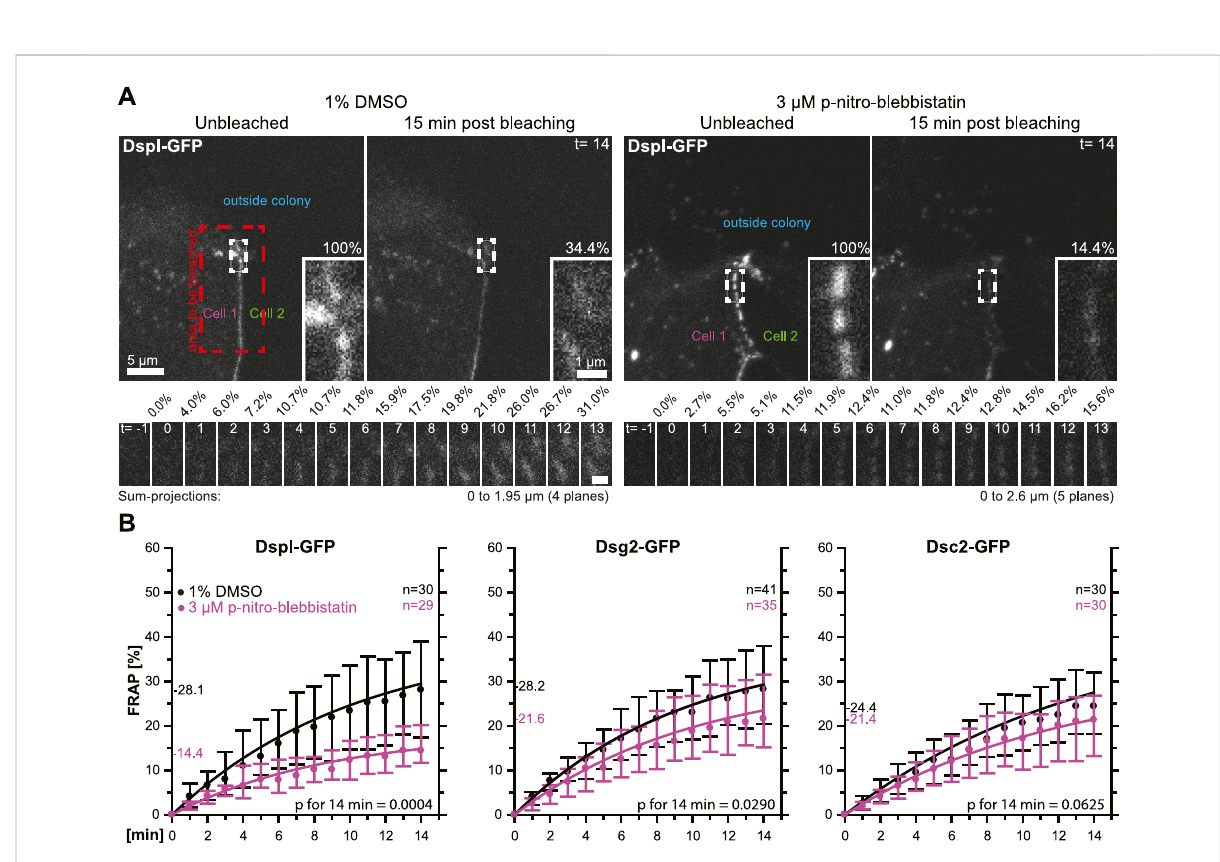
FIGURE 5 Myosin II inhibition decreases the desmosomal turnover of DspI and Dsg2 but not of Dsc2 in simple epithelial MDCK cells. MDCK cells were transfectedwith fl uorescently taggeddesmosomal proteinsand fl uorescencewas recorded incellsattheborder ofcolonies. (A) shows examples of fl uorescence recordings (sum-projections) in cells incubated with control medium (left) or with 3 µM para-nitro-blebbistatin (right) just prior to bleaching and 15 min after bleaching. Note that every fl uorescent cell is next to a non-transfected cell. The bleached regions of interest are presented as insets at higher magni fi cation. Below are images of the measured regions at the intermediate time points. (B) The diagrams show fl uorescence recovery curves of DspI-GFP, Dsg2-GFP and Dsc2-GFP that were started 1 min after bleaching. The experiments were performed as describedinFigure3C.Dotsrepresentmedians,whiskerscorrespondtothe25 – 75thpercentiles,andstatisticalanalysiswasperformedwithaMann- Whitney test at 14 min after the measurements were